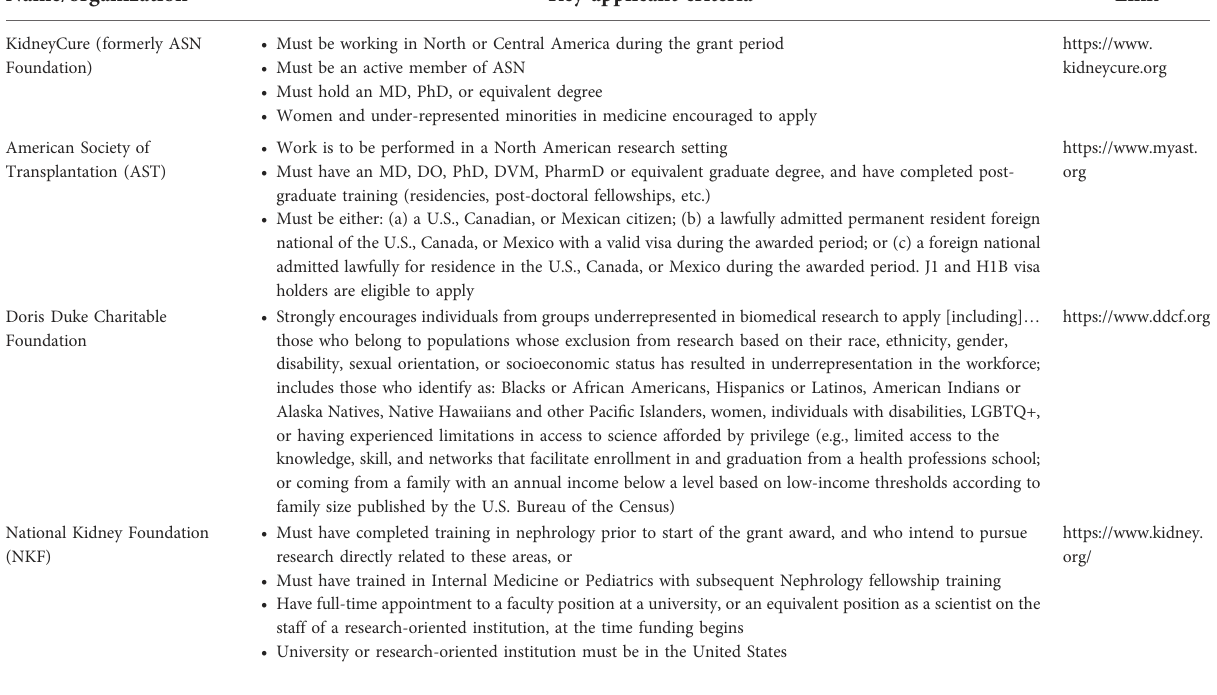
TABLE 2 Funding sources available to non-US citizen nephrology